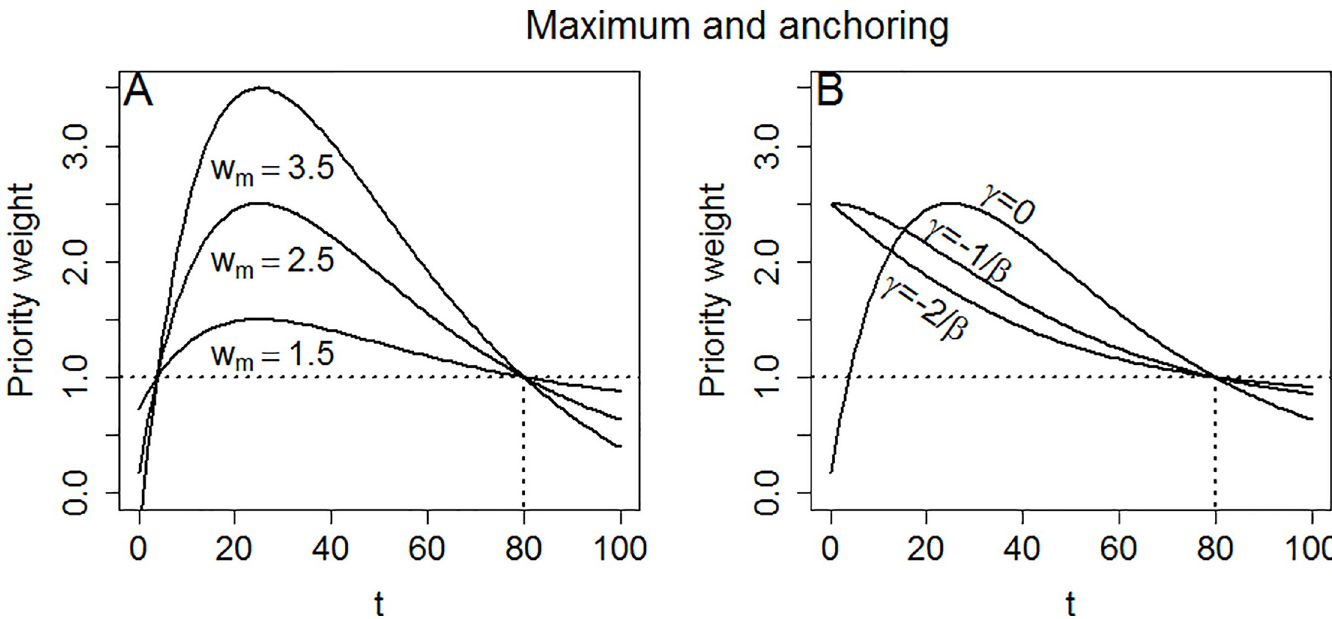
Fig 3. Anchoring to 1 for t = 80, with β = 0.04. Panel A: Varying max t ( w m ) when γ = 0 . Panel B: Varying γ when w m = 2.5 . For γ = 0 , there is no shift. For γ = − 1/ β the curve is shifted left so that the maximum is at t = 0 . For γ = − 2/ β the curve is shifted so that the slope is the steepest at t = 0 .